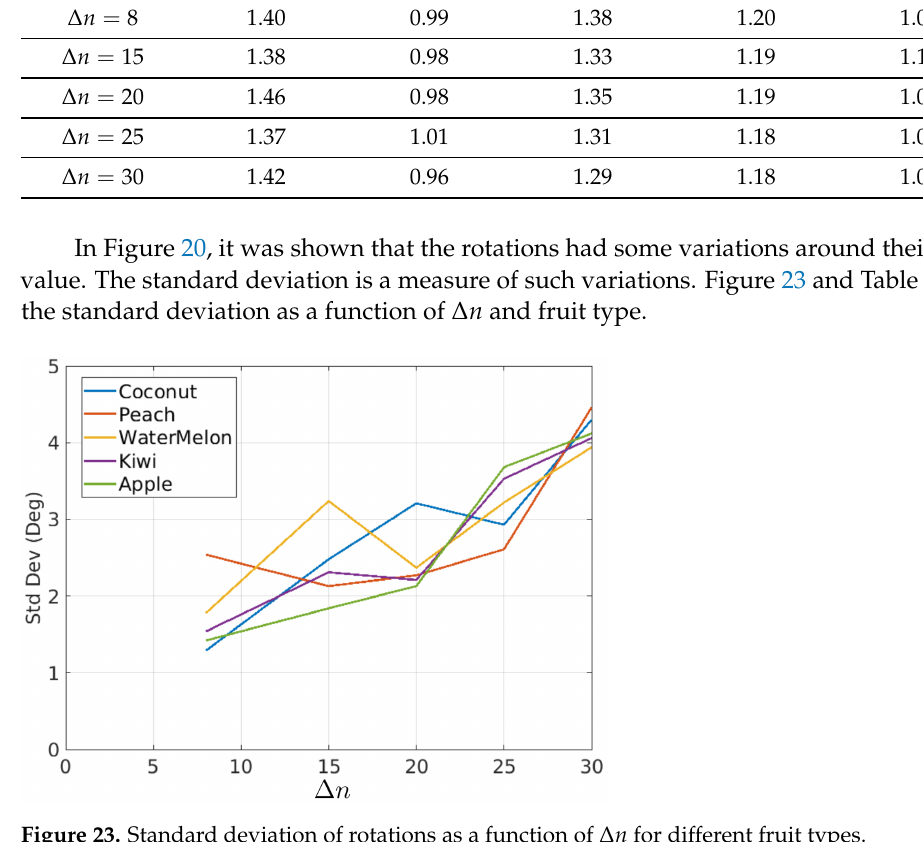
Figure 23. Standard deviation of rotations as a function of ∆ n for different fruit